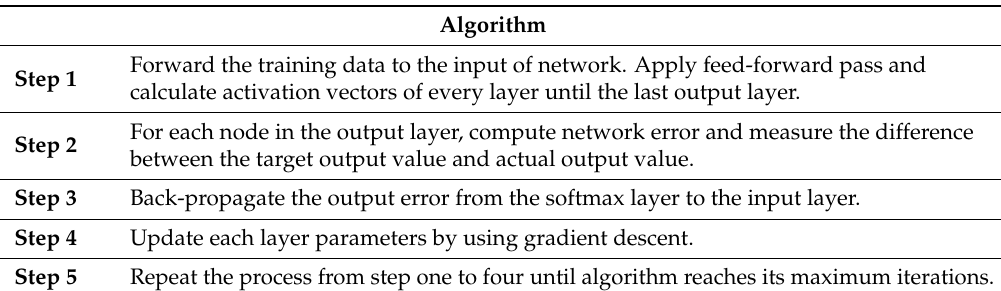
Table 3. Fine-tuning strategy using backpropagation.